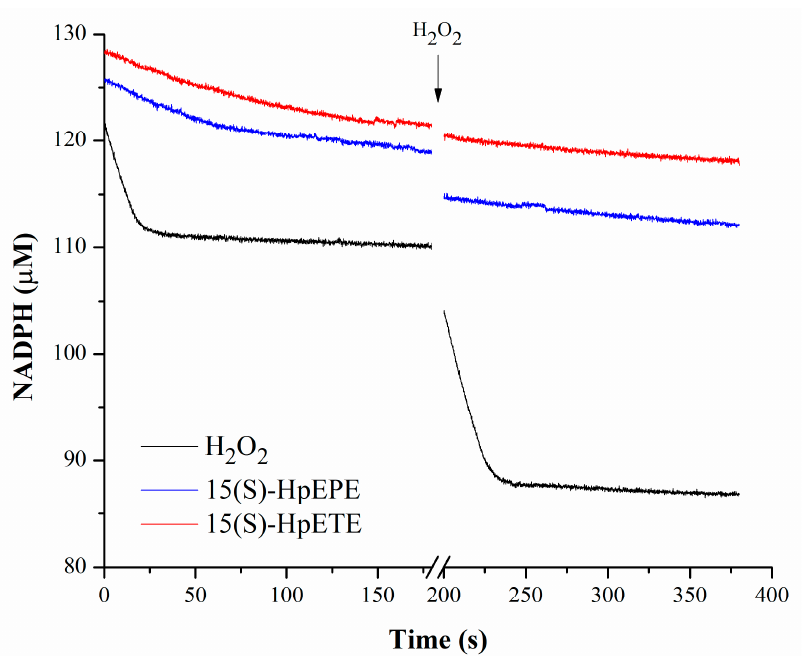
Figure 1. Inactivation of Hs Prx3 by f FA-OOHs. NADPH was pre-incubated with Eg TR (40 nM), Hs Trx1 (30 µ M) and Hs Prx3 (0.8 µ M) and rapidly mixed with the indicated oxidizing substrates (20 µ M) (black, H 2 O 2 ; blue, 15(S)-HpEPE; red, 15(S)-HpETE) in sodium phosphate buffer 50 mM plus 0.1 mM DTPA, pH 7.8 and 25 ◦ C. The arrow indicates the addition of H 2 O 2 (20 µ M) to the mixture. Table 1. Catalytic activity of Hs Prx3 using different oxidizing substrates.